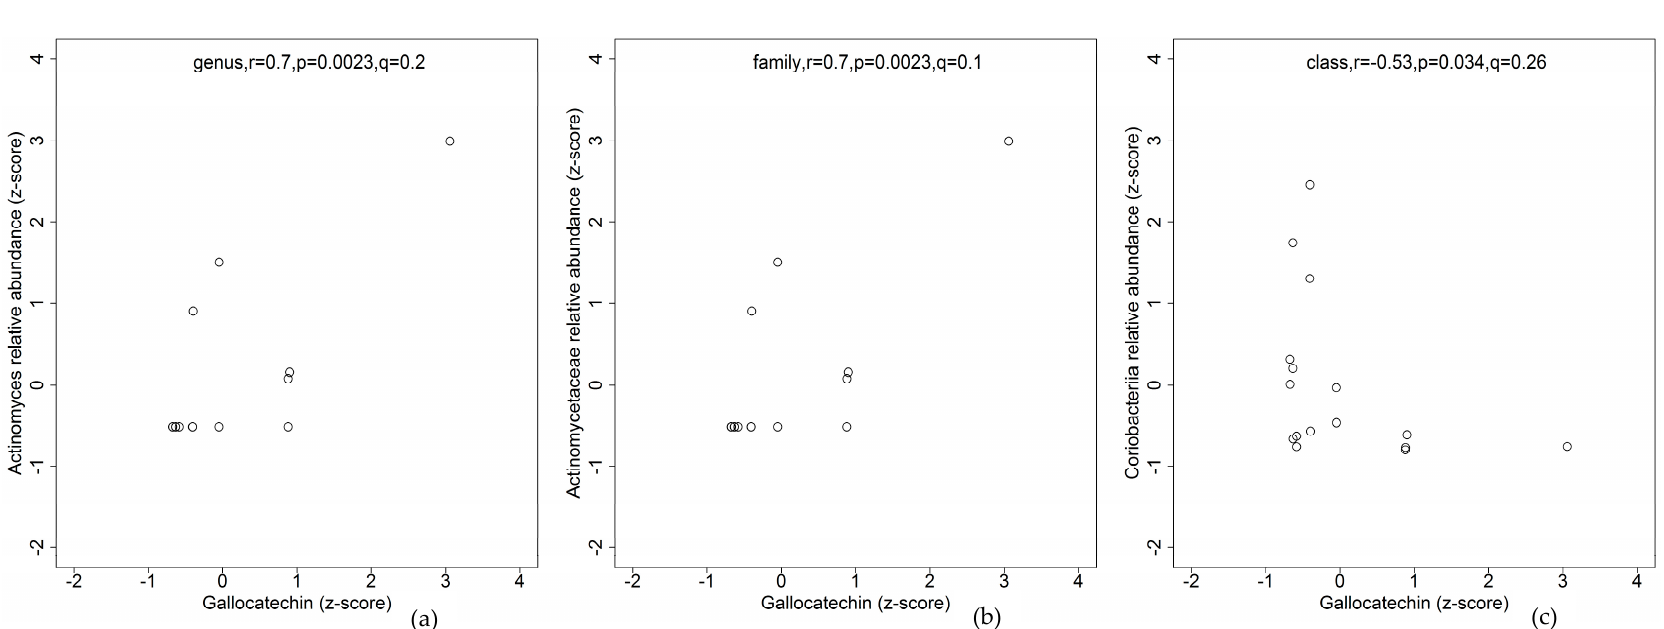
Figure 1. Spearman’s correlations between specific gut bacteria taxa and gallocatechin intake in a group of free-living adults with cystic fibrosis (CF). Positive correlations between gallocatechin intake and Actinomyces ( a ) and Actinomycetaceae ( b ), negative correlation between gallocatechin intake and Coriobacteriia ( c ); r = Spearman’s rho, p = raw p values, q = p values adjusted for multiple testing at an FDR < 0.3.